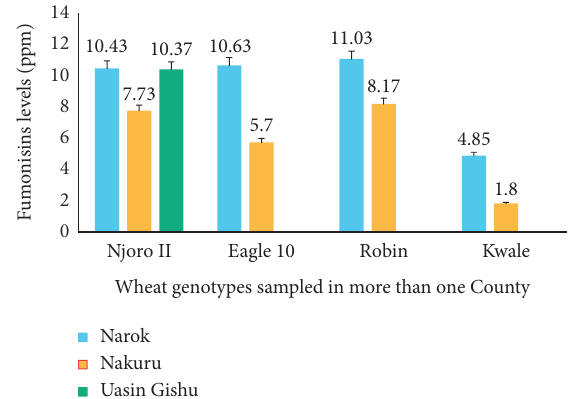
Figure 6: A comparison of fumonisin levels in the grains of Njoro II, Eagle10, Robin, and Kwale wheat genotypes in three agro- ecological Counties in